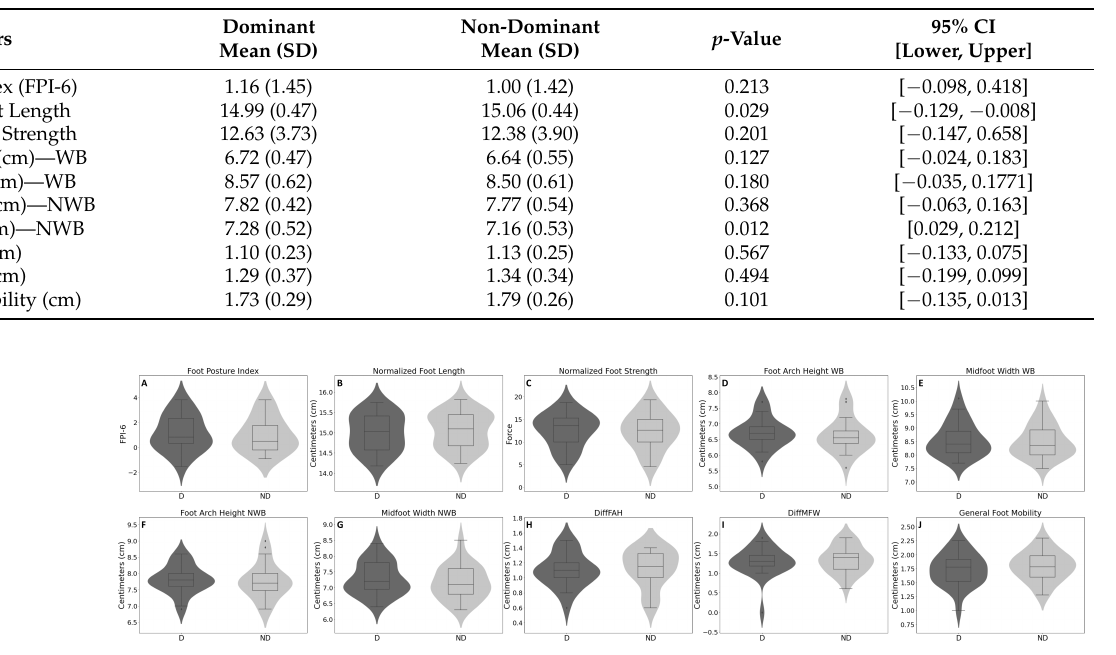
Figure 3. Boxplots and histograms of the variables: ( A ) Foot Posture Index (FPI-6); ( B ) normalized foot length; ( C ) normalized foot strength; ( D ) foot arch height—WB; ( E ) midfoot width—WB; ( F ) foot arch height—NWB; ( G ) midfoot width—NWB; ( H ) DiffFAH; ( I ) DiffMFW; and ( J ) general foot mobility. The violin plots show the data distribution, and the boxplots present the data locality, spread and skewness of dominant (black) and non-dominant (gray) feet.